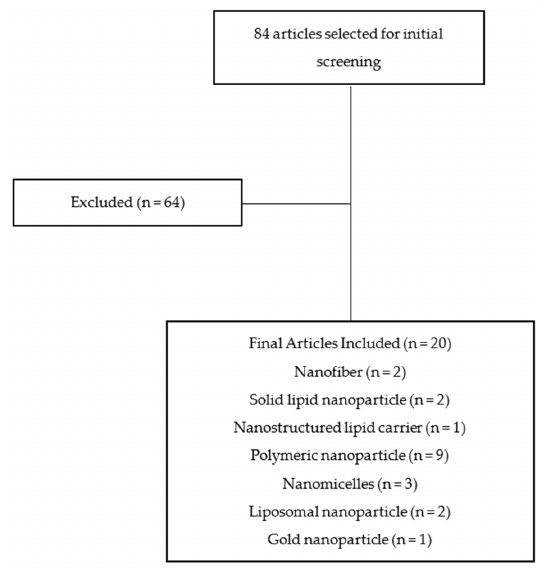
Figure 1. Flowchart of methodology.